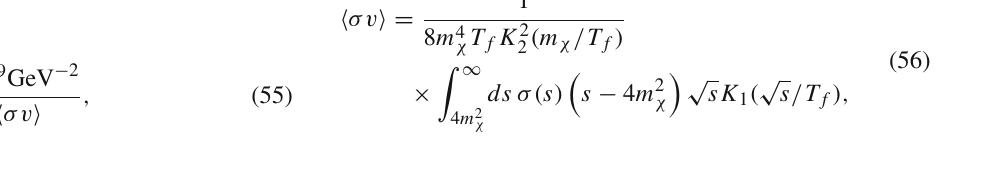
Fig. 7 Diagrams contributing to the DM coannihilation cross section with fermions in the final state. The diagrams shown in the first line correspond to the case where the DM candidate is a (potentially light) KK fermion χ 1 , whereas the diagrams in the second line correspond to the case where a mass insertion on a dark fermion line is needed in order to generate an effective interaction S 1 ¯ χ 0 χ 0